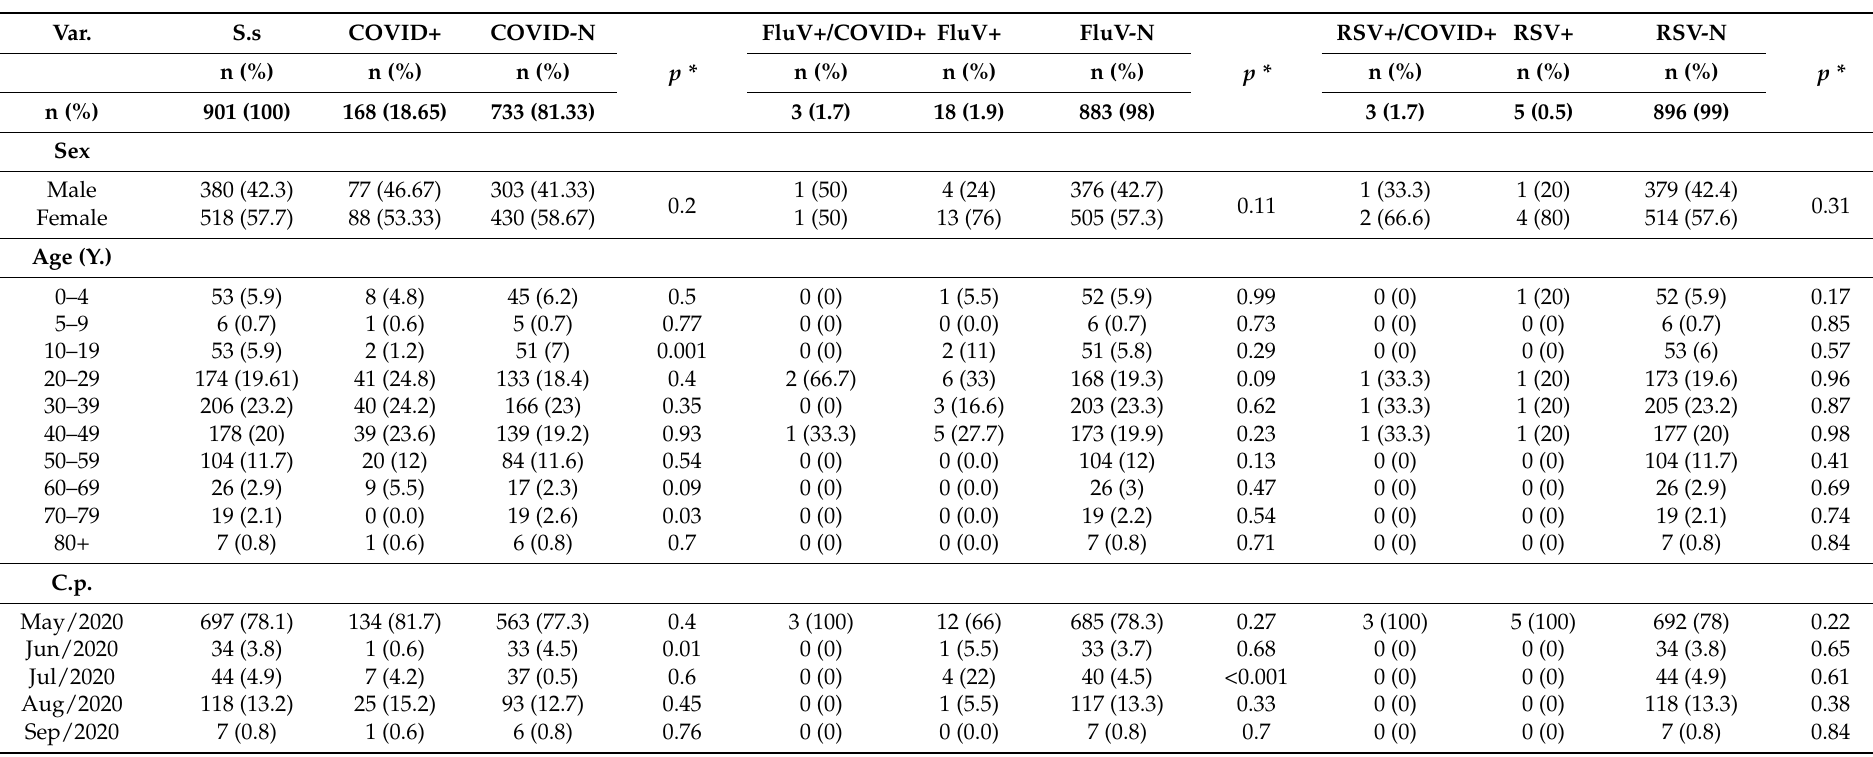
Table 1. Demographic characteristics of the study population according to the positivity of SARS-CoV-2, FluV, and RSV among suspected COVID-19